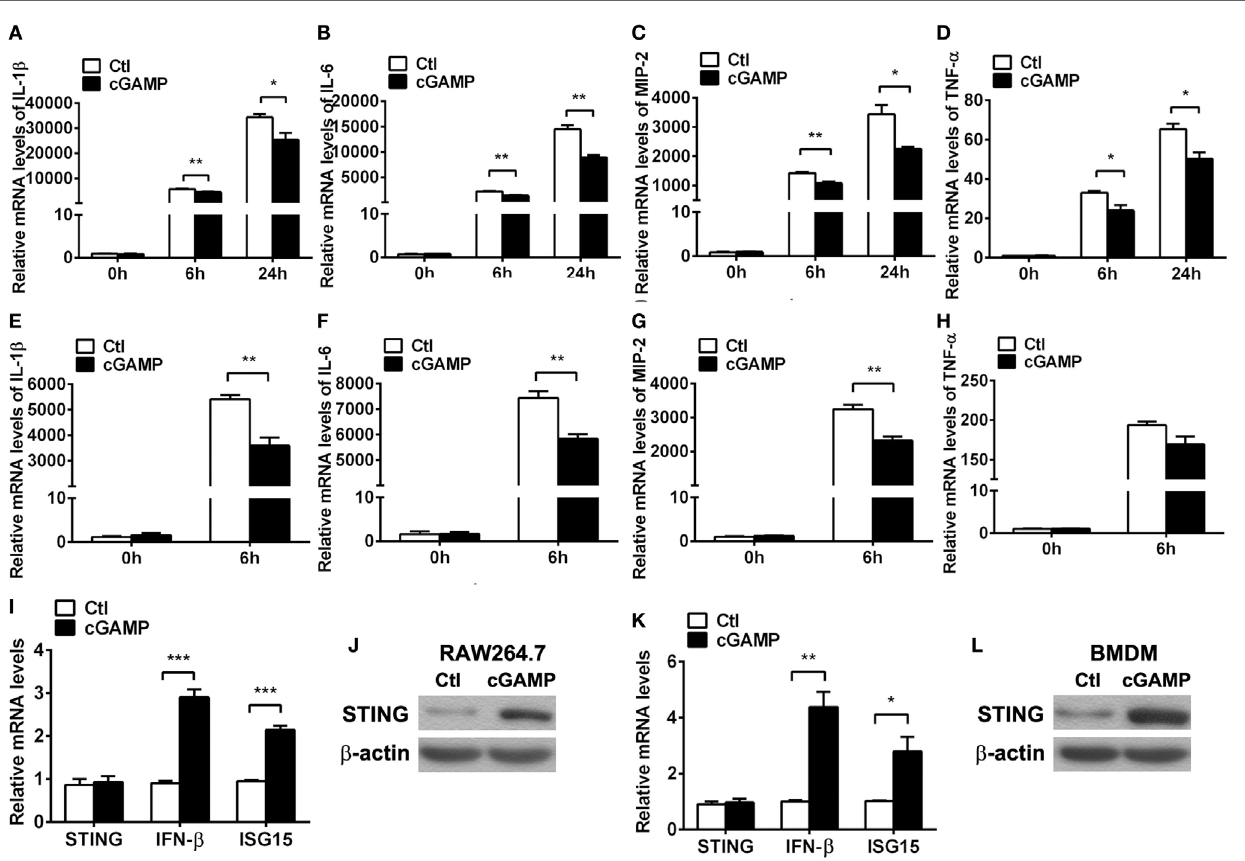
FigUre 6 | Activating stimulator of interferon genes (STING) inhibited inflammatory cytokine expression. (a–D) mRNA levels of interleukin 1 beta (IL-1 β ) (a) , interleukin 6 (IL-6) (B) , macrophage inflammatory protein 2 (MIP-2), (c) and tumor necrosis factor α (TNF- α ) (D) were measured by using real-time PCR at 6 and 24 h postinfection (p.i.) in murine macrophage-like RAW264.7 cells with 2 ′ ,3 ′ -cGAMP (cGAMP) versus control treatment. (e–h) mRNA levels of IL-1 β (e) , IL-6 (F) , MIP-2 (g) , and TNF- α (h) were measured by using real-time PCR at 6 h p.i. in bone marrow-derived macrophages with cGAMP versus control treatment. (i,K) mRNA levels of STING, IFN- β , and interferon-stimulated gene 15 (ISG15) were measured by using real-time PCR in RAW264.7 cells (i) and bone marrow-derived macrophage (BMDM) (K) with cGAMP versus control treatment. (J,l) Protein levels of STING were measured by using Western blot in RAW264.7 cells (J) and BMDM (l) with cGAMP versus control treatment. Data are shown as mean ± SEM of three independent experiments. * P < 0.05; ** P < 0.01; and *** P <